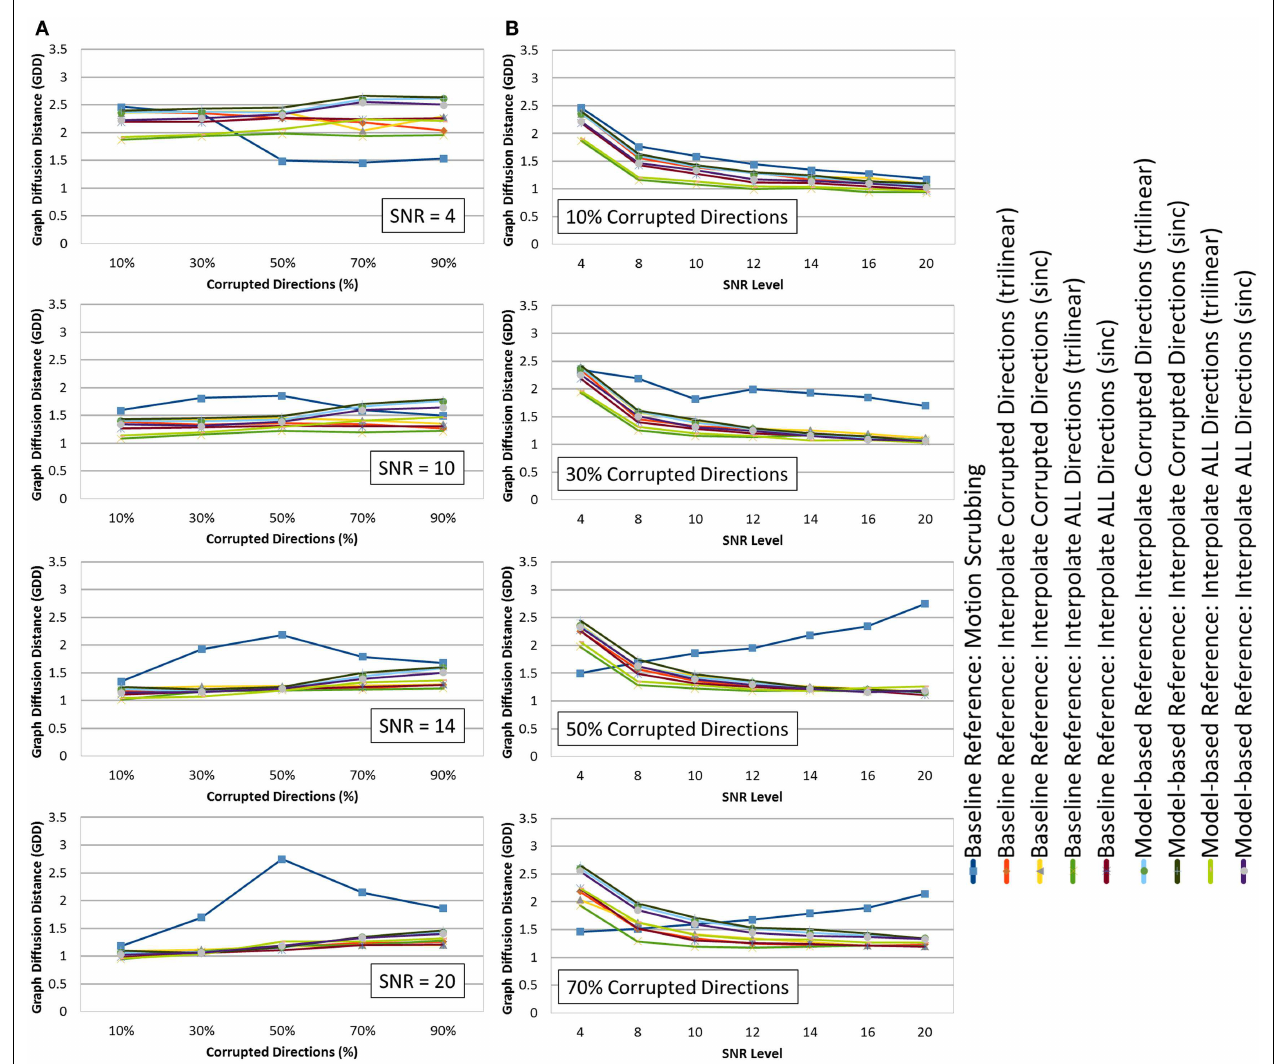
FIGURE 6 |The average graph diffusion distance (GDD) (lower is better) for the whole brain tractography derived from the raw datasets (denoised ones share similar performance) as (A) a function of the corrupted directions percentage for different SNR levels and (B) a function of SNR